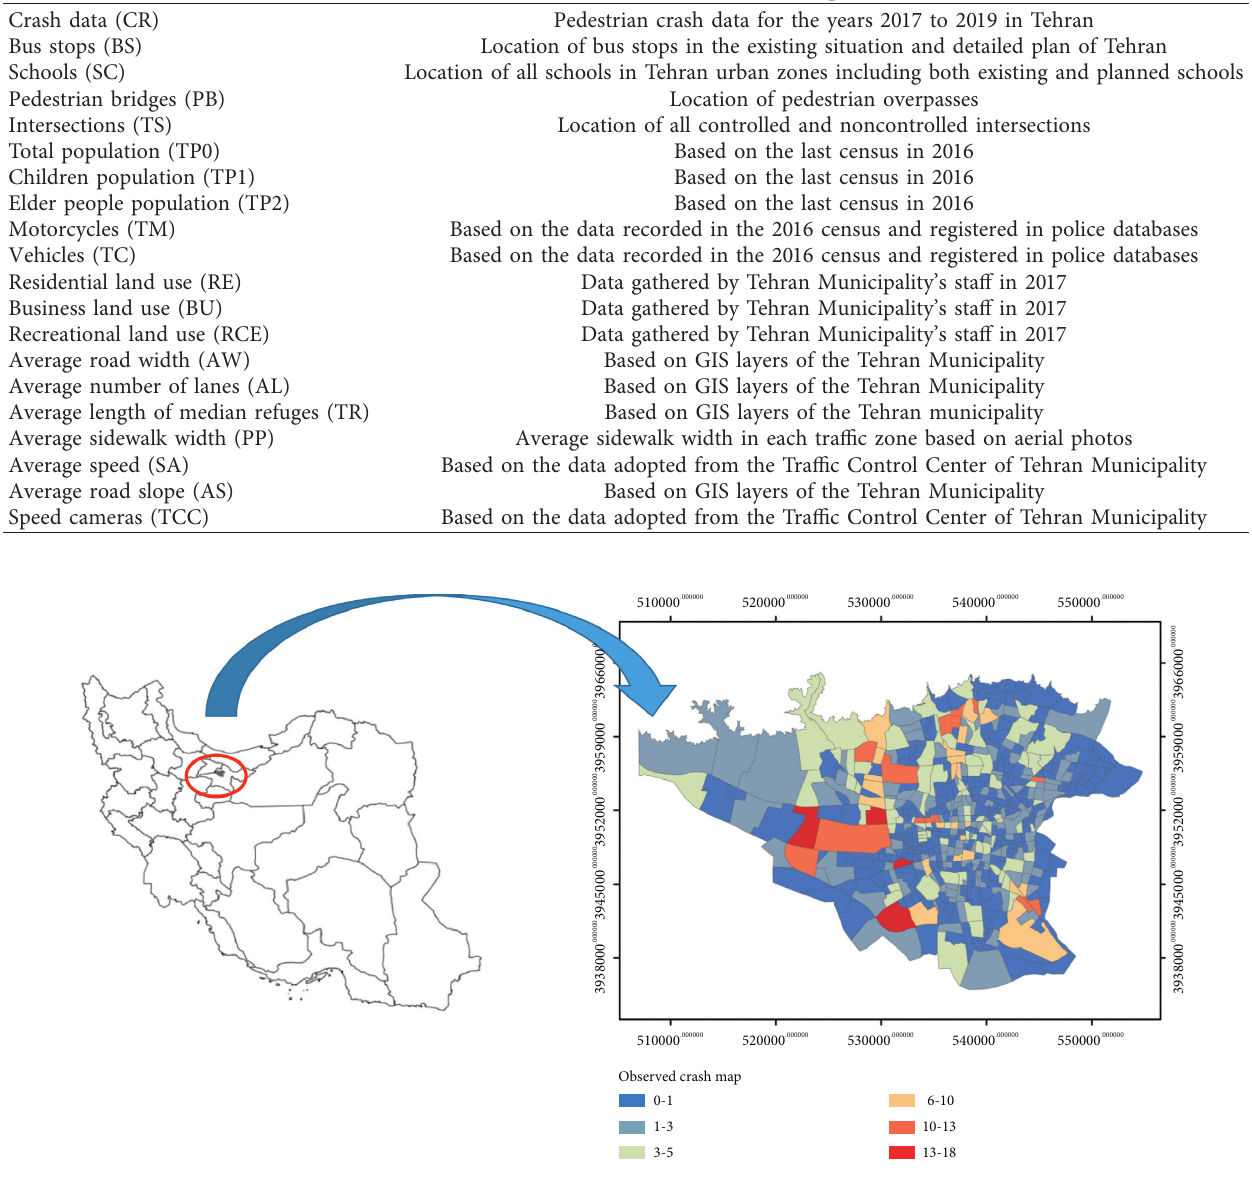
Figure 1: The study area and the status of existing